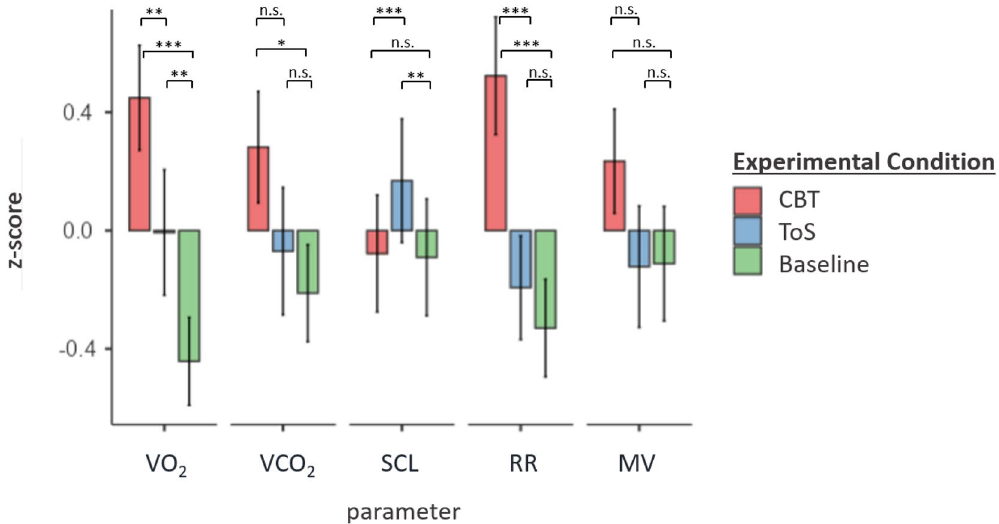
Figure 2. Mean values of physiological measures across experimental conditions (absolute perspective). Note. Due to scaling differences of EDA and gas parameters, mean values presented in this figure were z-standardized for each parameter. CBT = Corsi-Block-Tapping-Task, ToS = Threat-of-Shock; VO 2 = Volume of oxygen uptake, VCO 2 = Volume of carbon dioxide output, SCL = Skin conductance level, RR = Respiratory Rate, MV = Minute Volume; error bars indicate standard deviation. * p < .05, ** p < .01, *** p <